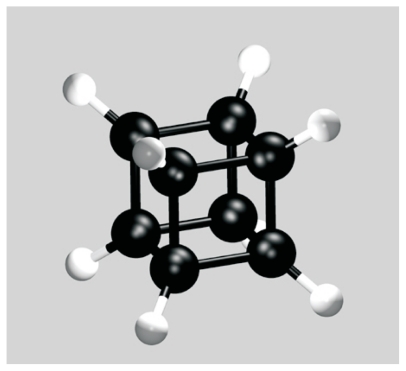
A C8H8 molecule.